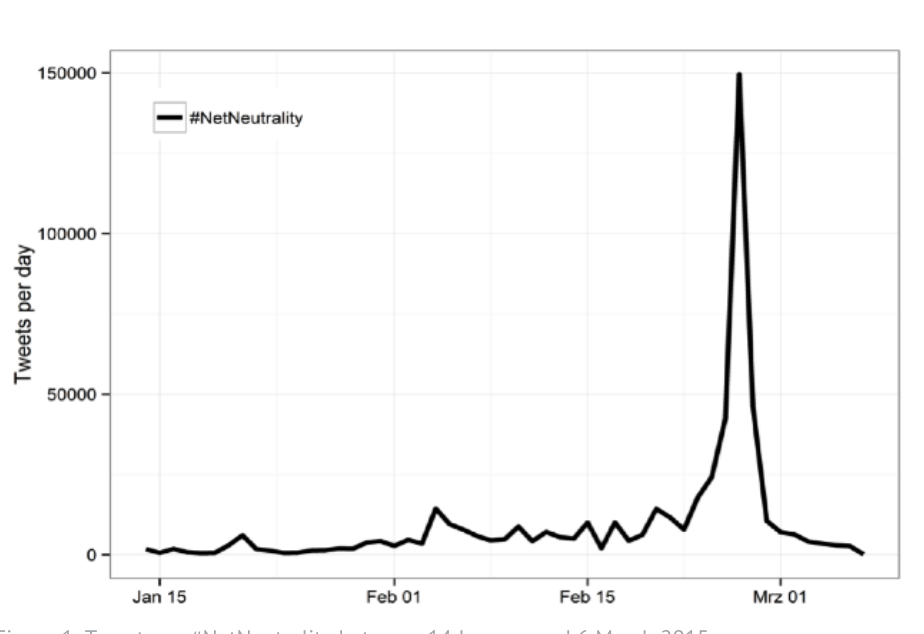
Figure 1: Tweets on #NetNeutrality between 14 January and 6 March